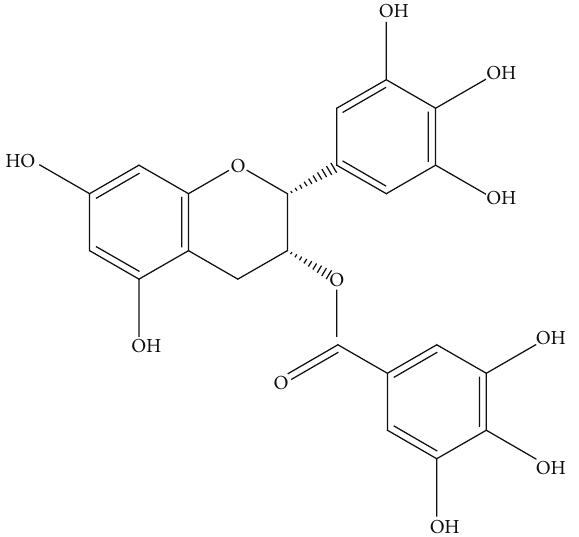
Figure 1: Structures of epigallocatechin-3-gallate (EGCG).